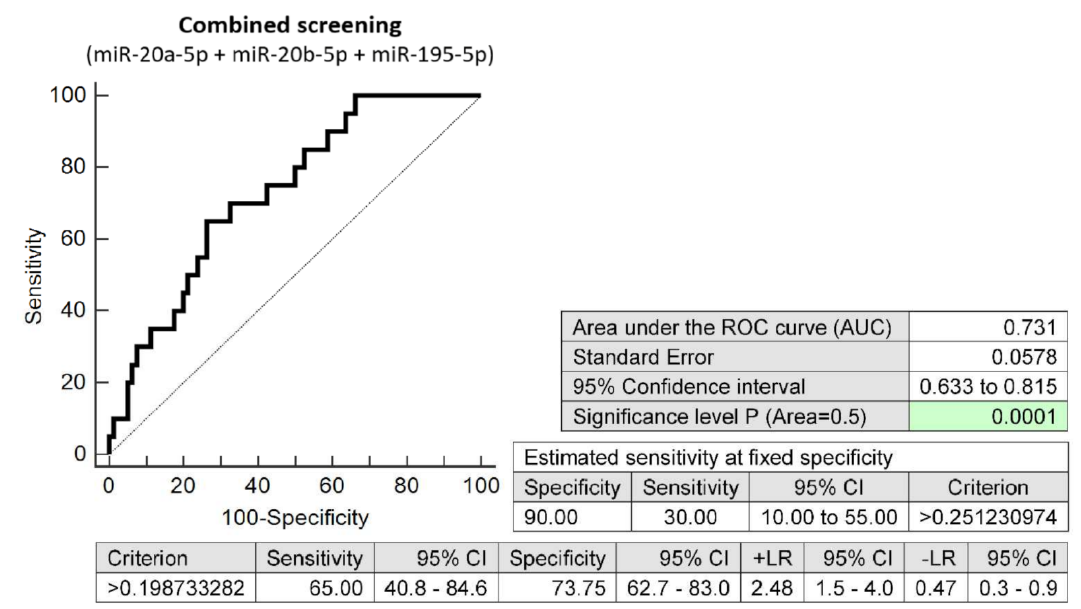
Figure 5. ROC analysis—the combination of microRNA biomarkers (miR-20a-5p, miR-20b-5p and miR-195-5p). A total of 30.0% pregnancies destinated to develop GDM requiring a combination of diet and administration of appropriate therapy had aberrant microRNA expression profile in the whole peripheral venous blood during the first trimester of gestation at a 10.0% FPR. This represents 6 out of 20 pregnancies correctly predicted to develop GDM and 8 out of 80 normal pregnancies predicted false positively to develop GDM.